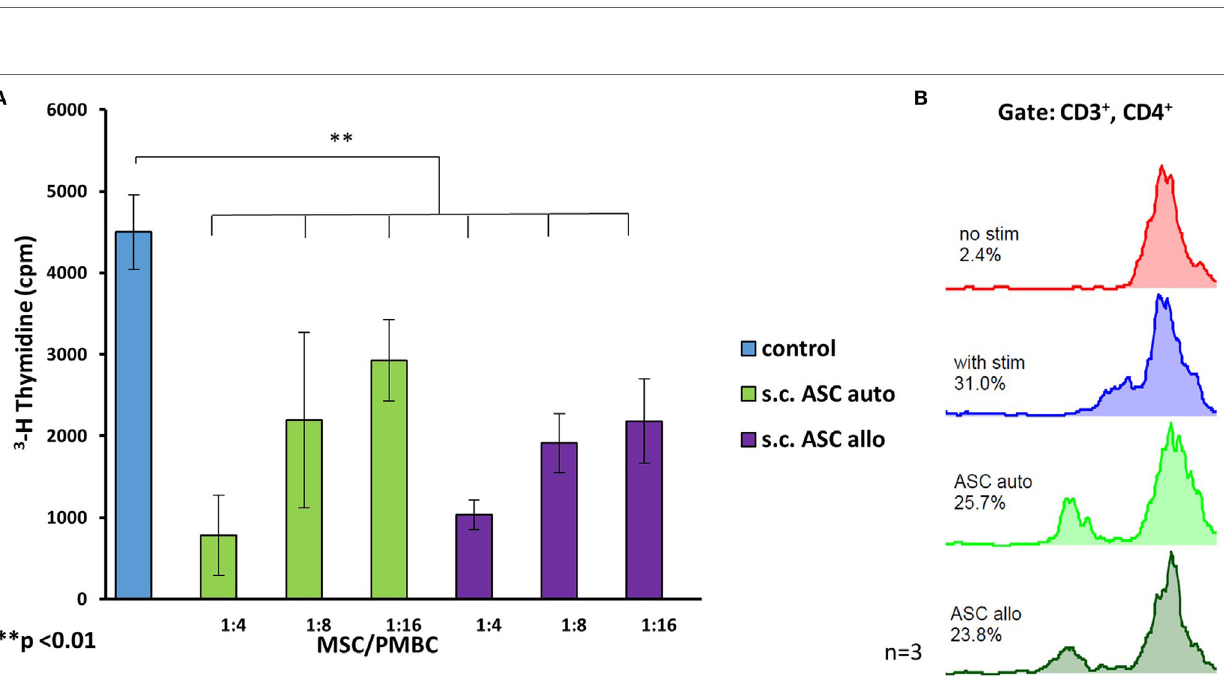
FigUre 5 | The comparison of immunomodulating potency between autologous and allogenic s.c.ASC (a) revealed no statistical significance. Three biological replicates ( n = 3) with three different donor/recipient combinations were analyzed. All cells demonstrated a dose-dependent suppression in a tritiated thymidine assay. Panel (B) shows a representative carboxyfluorescein succinimidyl ester mixed lymphocyte reaction stimulated by allogenic splenocytes: allogeneic (ASCsyn) ASC showed similar suppressive potential if compared with allogeneic ASC (ASCallo) or bone marrow-derived mesenchymal stem cells on CD3 + , CD4 + cells (B) .